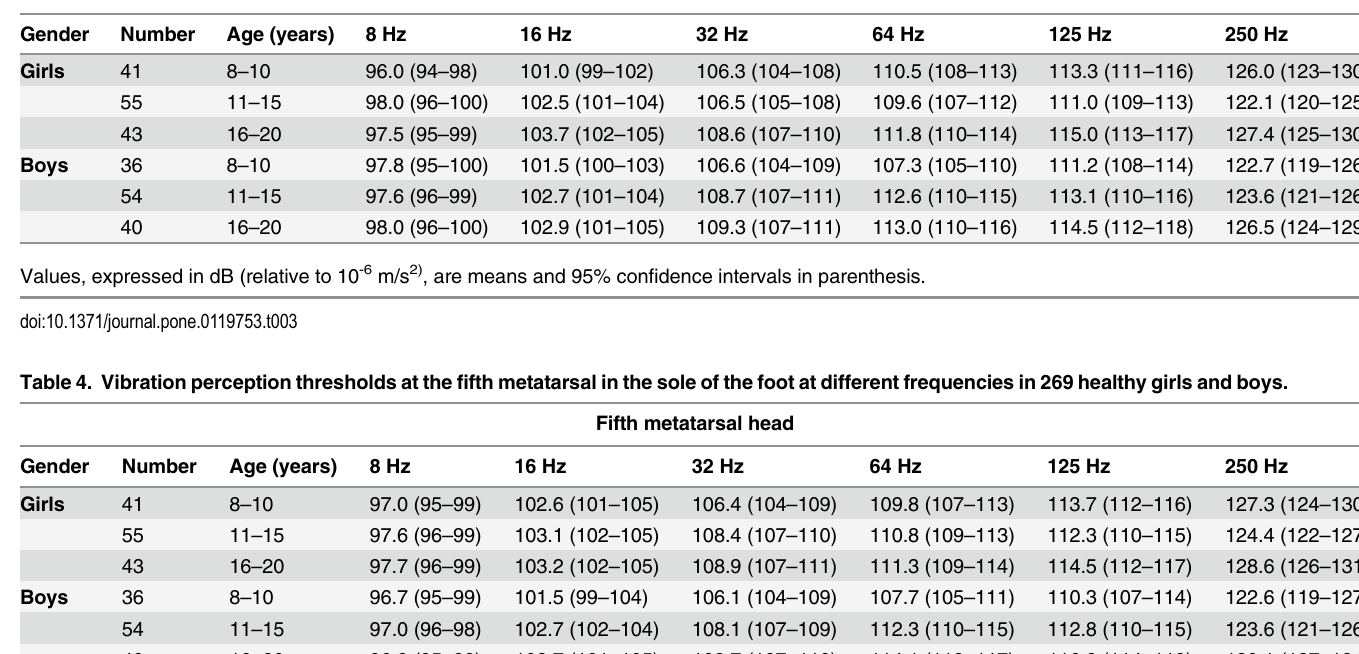
Table 3. Vibration perception thresholds at the first metatarsal head in the sole of the foot at different frequencies in 269 healthy girls and boys. First metatarsal head